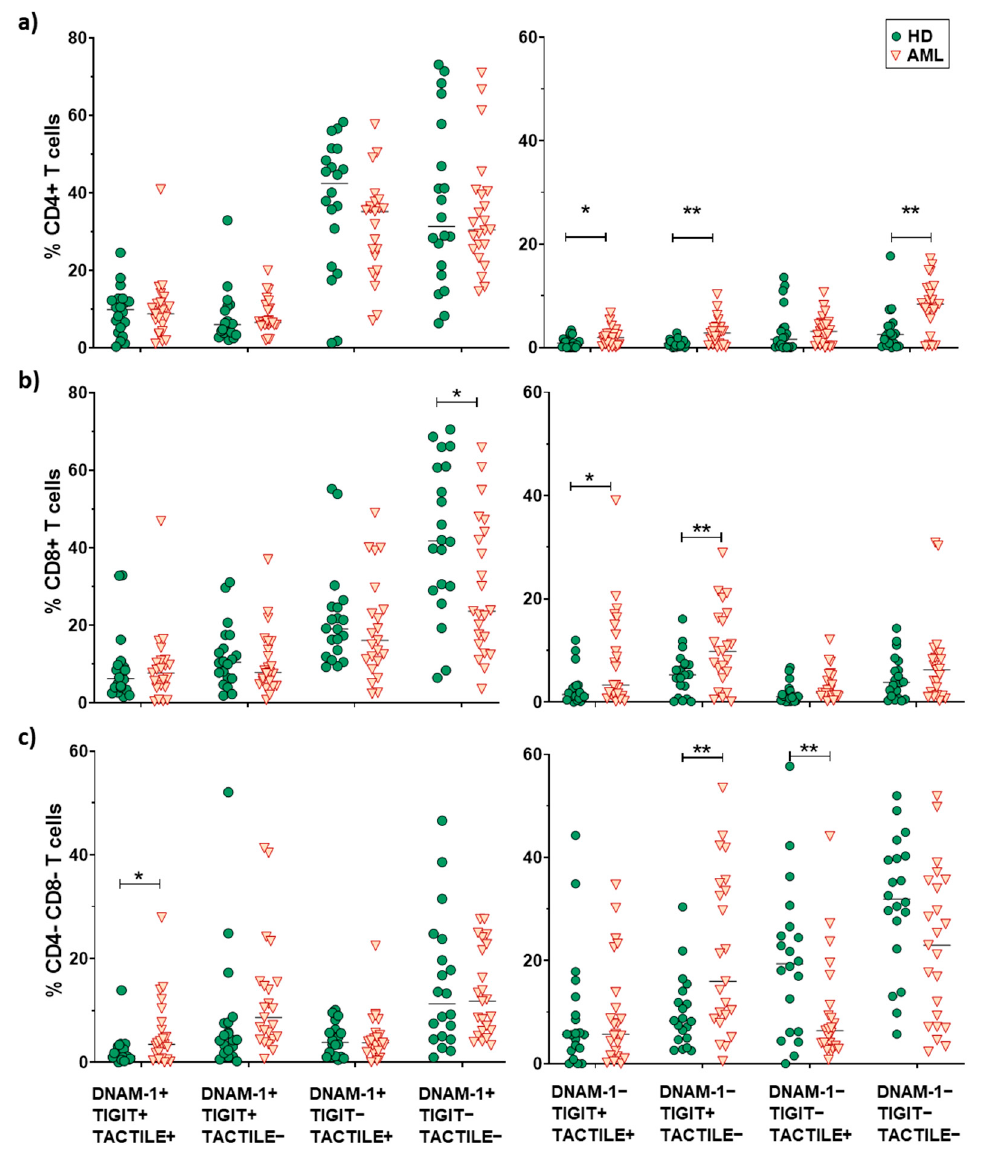
Figure 6. Analysis of DNAM-1, TIGIT and TACTILE co-expression in CD4+, CD8+ and CD4 − CD8 − T cell subsets. Eight different subpopulations can be observed according to the co-expression of DNAM-1, TIGIT and TACTILE. The distribution of these subsets in CD4+ T cells ( a ), CD8+ T cells ( b ) and CD4 − CD8 − T cells ( c ) in HD ( n = 20) and AML patients ( n = 23) is shown. The median values are indicated by a horizontal black line. Results were considered significant at * p < 0.05 and ** p < 0.01.